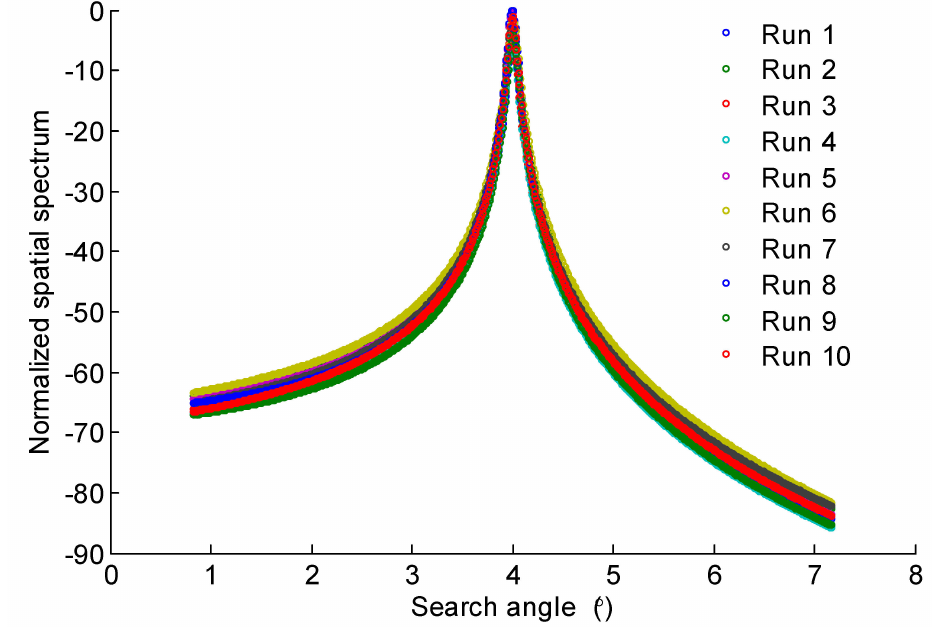
Figure 4. Search range results of 10 independent experiments based on generalized MUSIC after BOMP